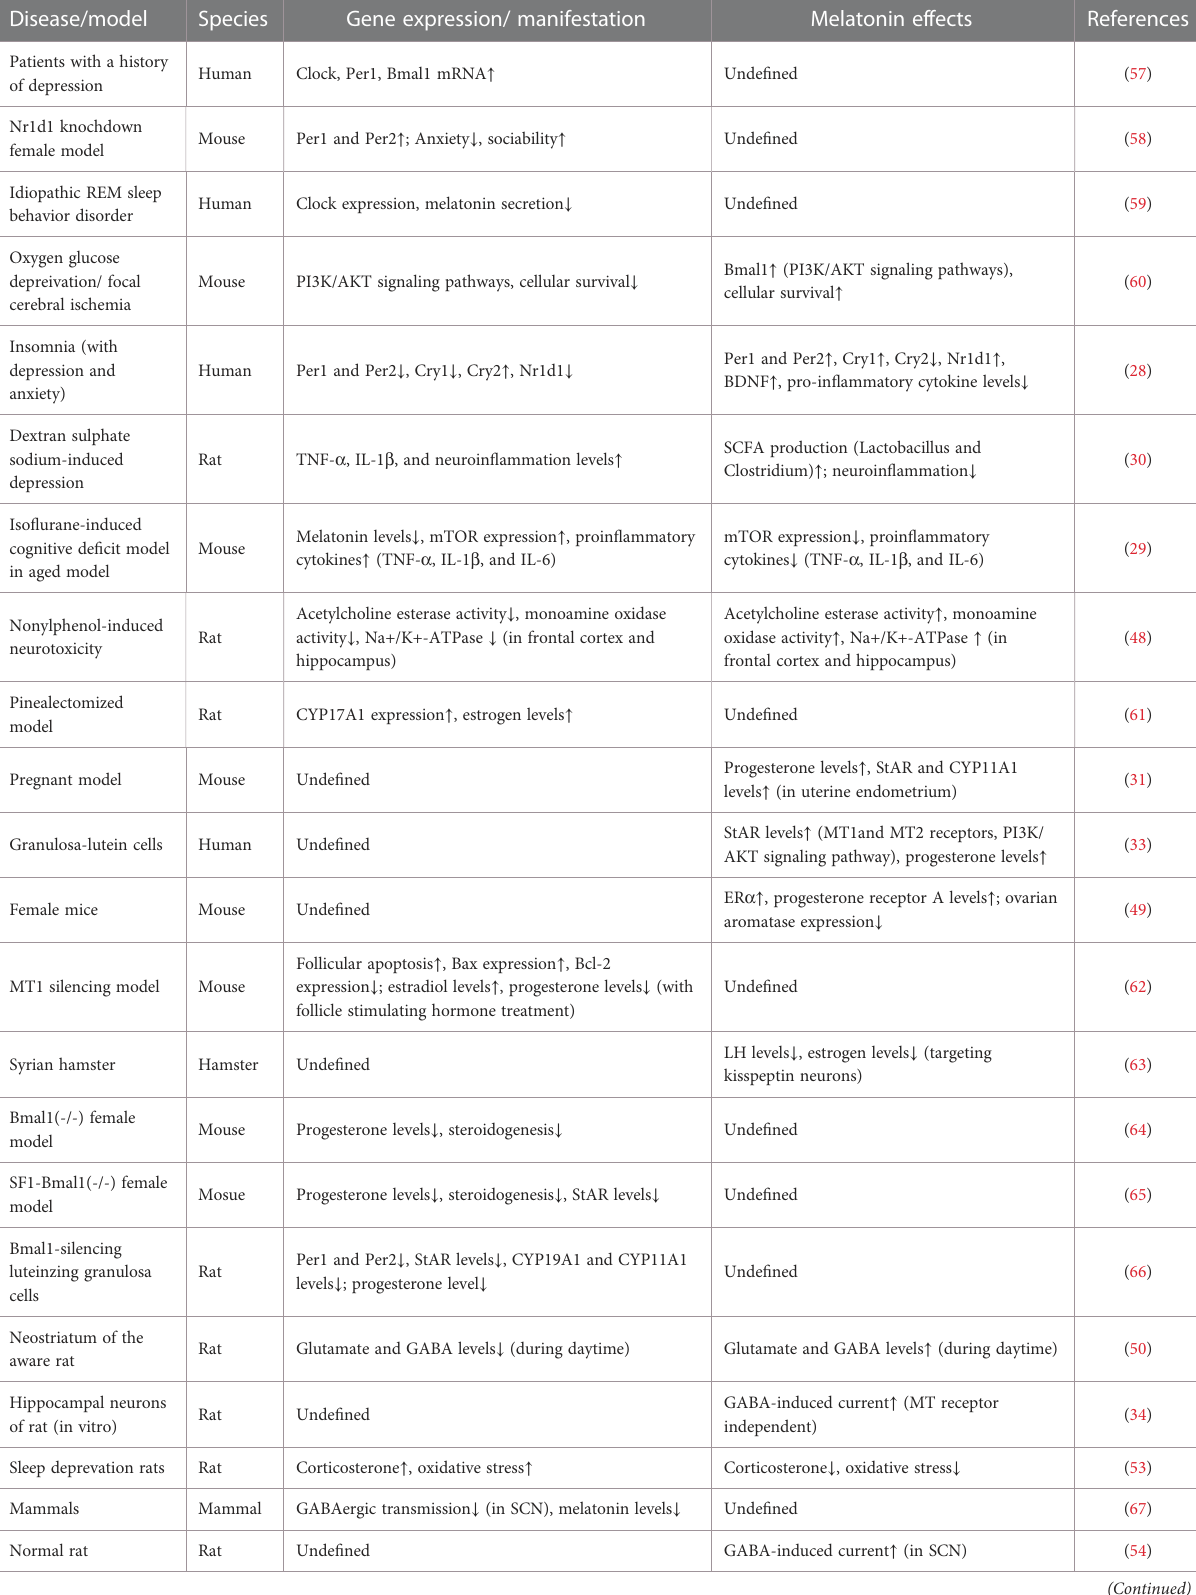
TABLE 3 Expression changes and melatonin effects in PMS/PMDD-related symptoms and animal models.